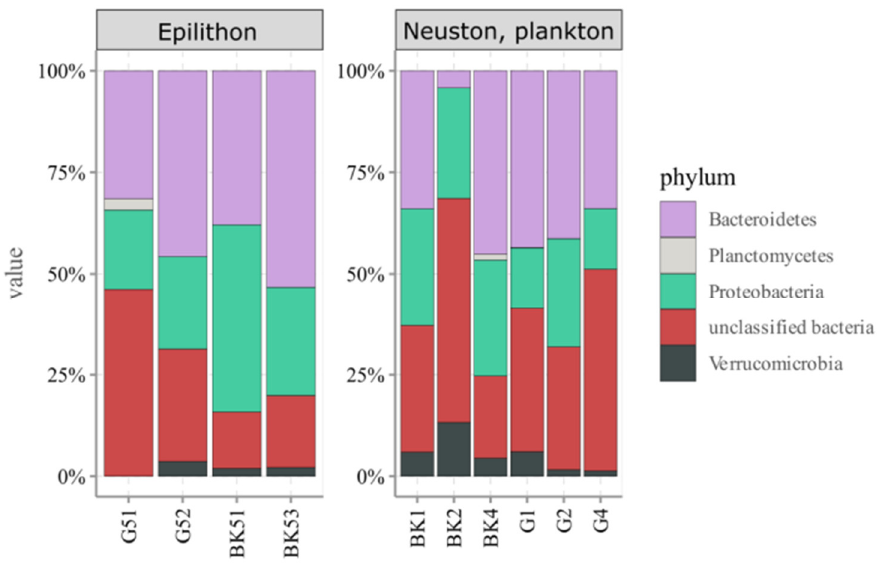
Figure 7. Taxonomic identification of rhodopsin gene reads of epilithon (G51, G52, BK51, BK53), neuston (BK1, G1), and plankton (BK2, BK4, G2, G4) of Lake Baikal at the phylum level. BK—samples taken off the Bol’shiye Koty settlement; G—samples taken off the Bol’shoye Goloustnoye set- tlement. Table 5. Rhodopsin gene sequences detected in Lake Baikal identified to the genus level. Number of Seqs in Number of Seqs in Closest Homologue Acces- ESV Genus Water Microbiomes Epilithon sion Number 1901, 2299